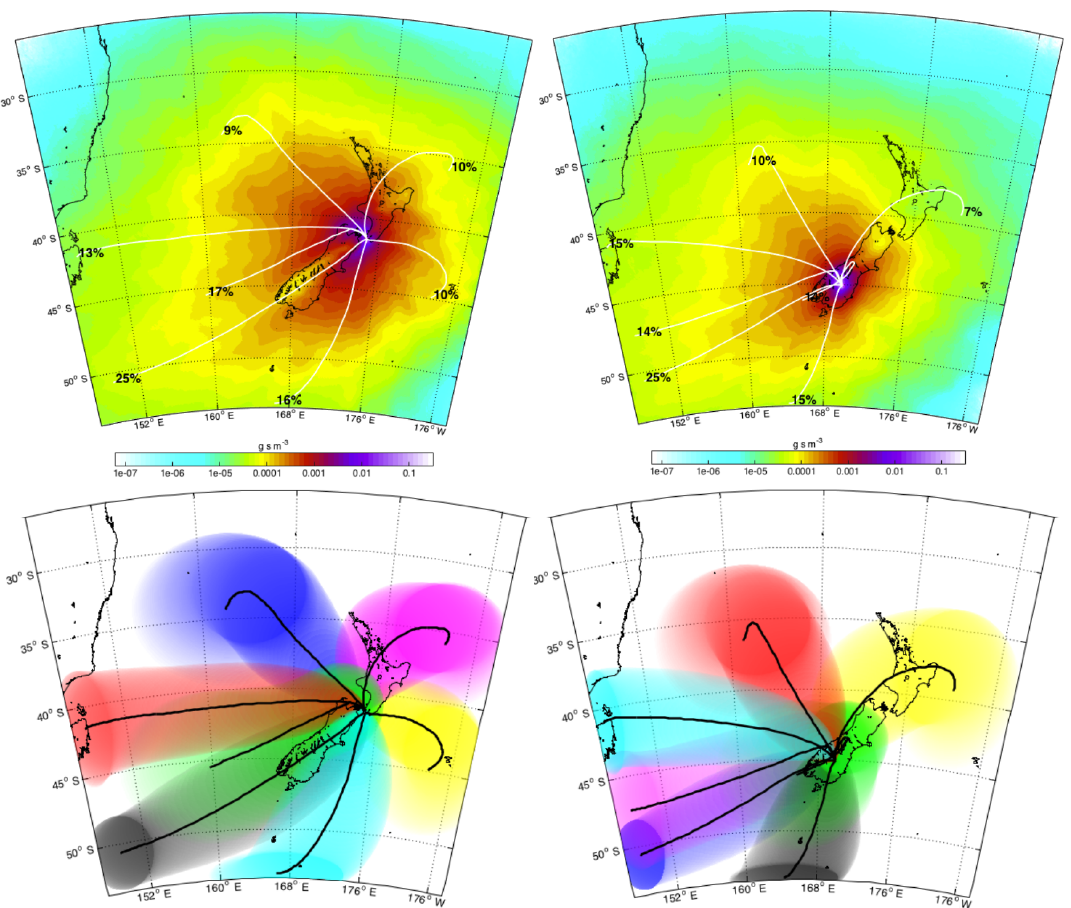
Figure 4. Top panel: 2011–2013 mean footprints for BHD and LAU stations, based on twice-daily air history maps at 13:00–14:00 and 15:00–16:00LT. Clusters of 4-day back trajectories are overlain. Percentages give the sizes of clusters, i.e. the probability that a particle released on a random day has followed that pathway. Lower panel: major atmospheric transport pathways for both stations from cluster analysis of the back trajectories from twice-daily particle release. Shades represent the geographical spread of each pathway (1 standard deviation from cluster centroid in